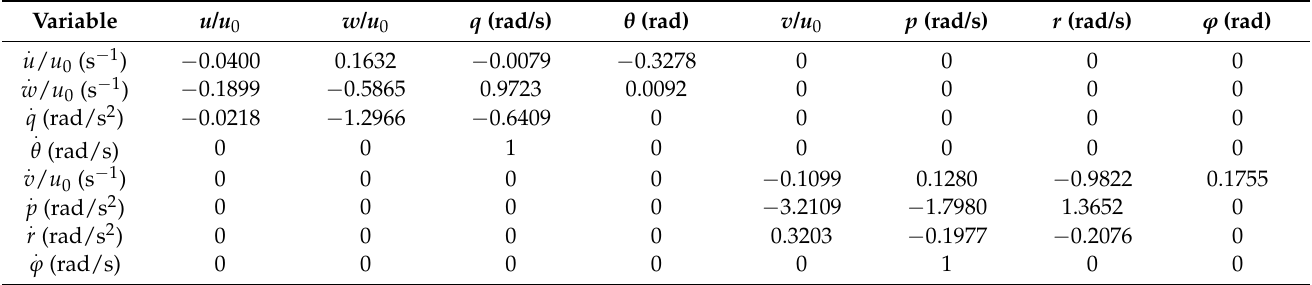
Table 7. Baseline 8 × 8 stability matrix for flight condition 1 in Tables 4 and 5 (reference landing case).